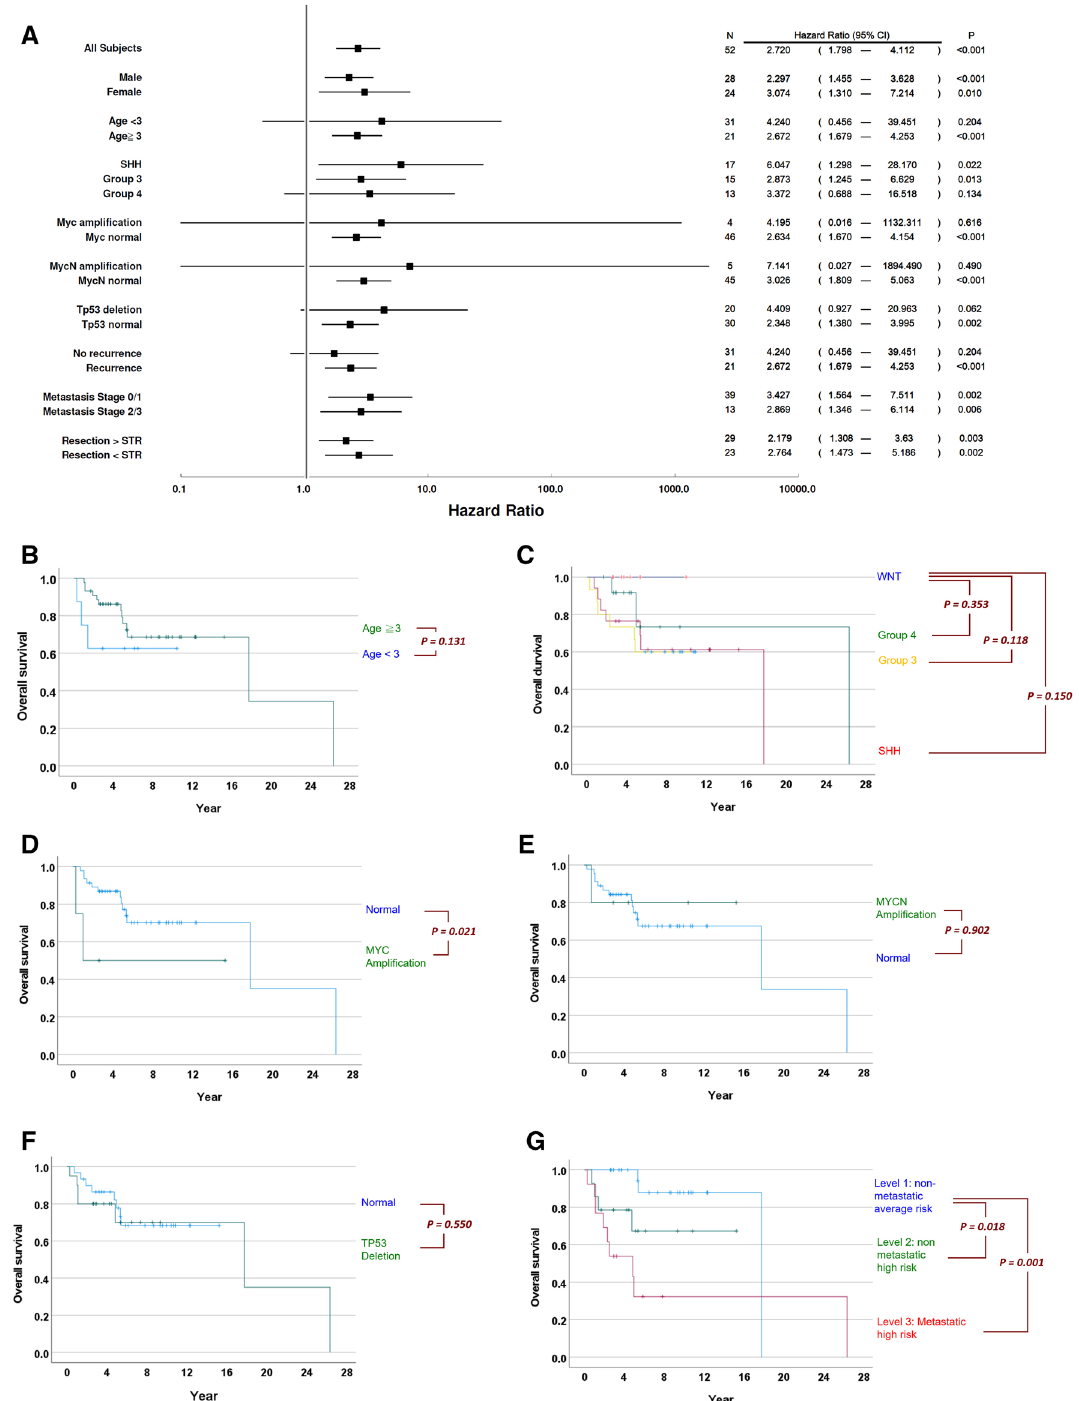
Figure 2. Evaluation of gene-signature score performances in various clinical subgroups. ( A ) The forest plot of the overall survival hazard ratios with respect to the gene-signature derived score in various clinical subgroups. Horizontal bars indicate the 95% confidence intervals of the hazard ratios. ( B ) The overall survival of patients stratified by age < 3 and ≧ 3. ( C ) The overall survival of patients stratified by molecular subgroups. ( D ) The overall survival of patients stratified with respect to somatic MYC amplification. ( E ) The overall survival of patients stratified with respect to somatic MYCN amplification. ( F ) The overall survival of patients stratified with respect to somatic TP53 deletion. ( G ) The overall survival of patients stratified by the clinical risk stratification scheme. P values in the Kaplan–Meier plots were calculated by the Breslow